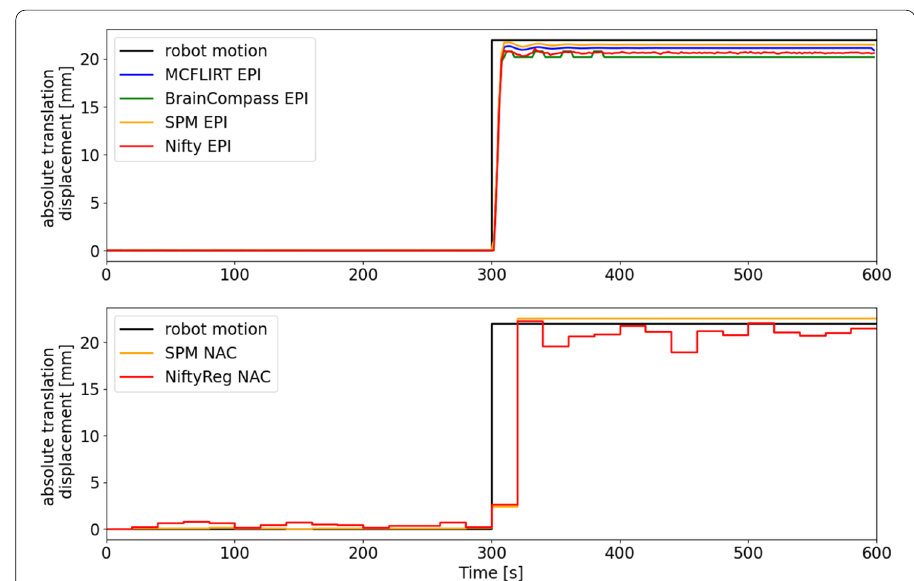
Fig. 11 Comparison of different registration methods on a single translation movement. The robotic movement (black line) symbolizes the ground truth. Upper image: EPI-based; lower image: NAC-based. Shown is the absolute translation displacement depending on time